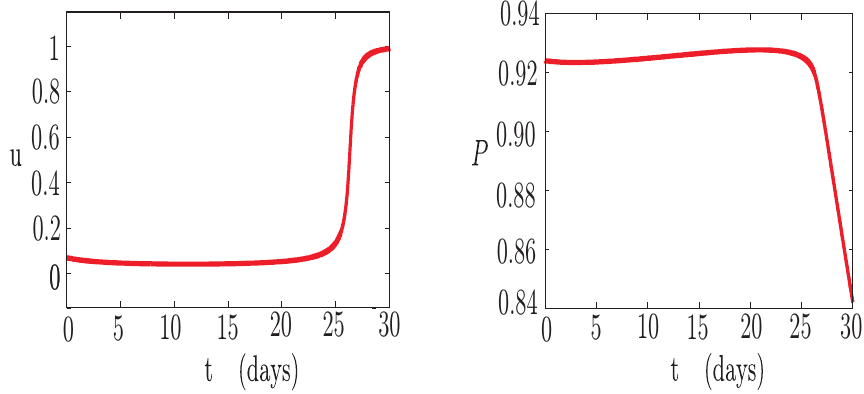
Fig. 9 Optimal solution for functional J w ( u ) in (29) with w = w s = 0 . 004067 and total dose M = 5; the time horizon is 30 days. (left) optimal control u ∗ ( t ) which is totally singular on [ 0 , 1 ] , (right) proliferative cells P .